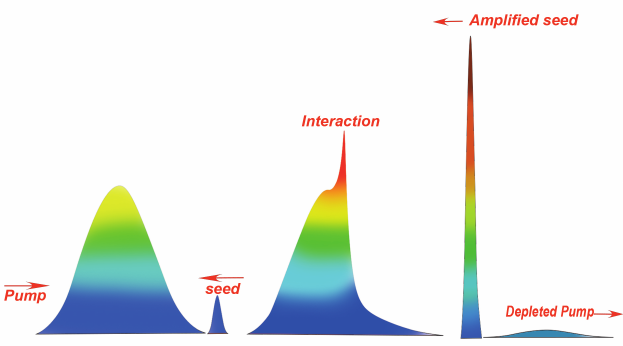
Figure 2. Schematic of laser amplification via stimulated Raman scattering and stimulated Brillouin